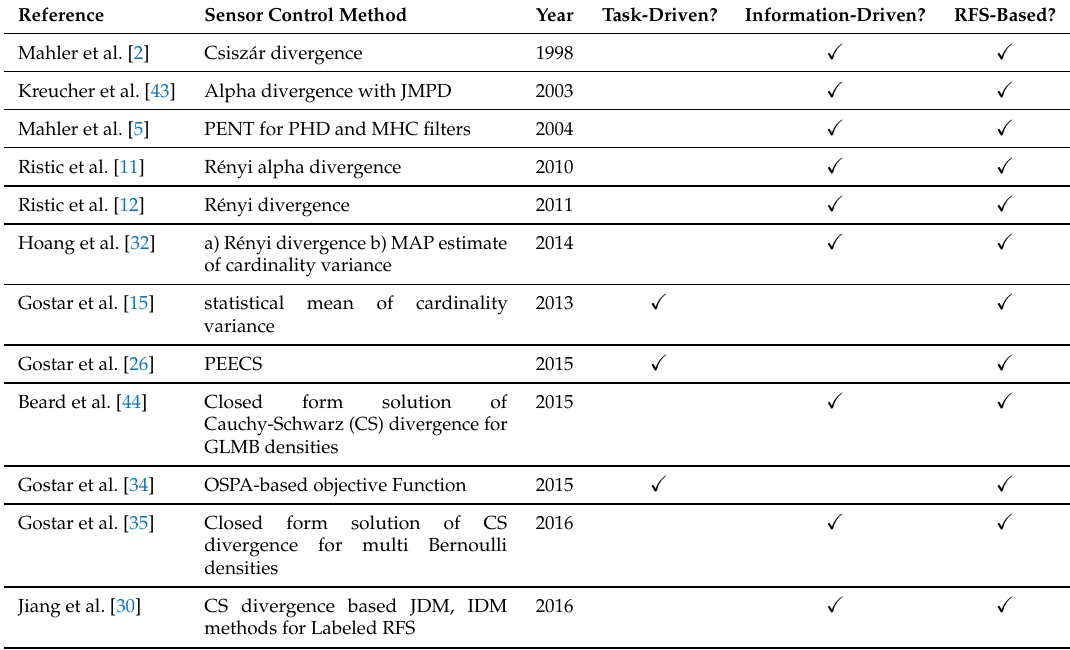
Table 1. Sensor control